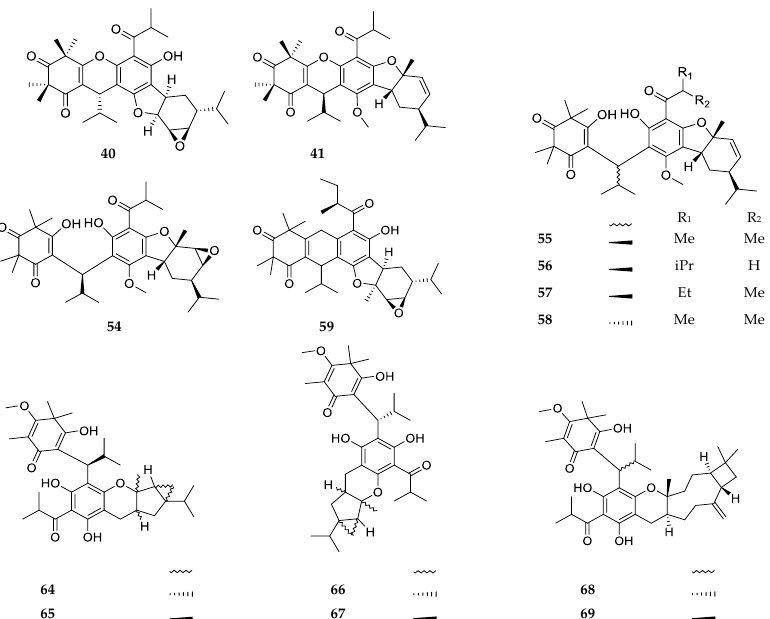
Figure 8. Structures of compounds of the terpene-adduct type.